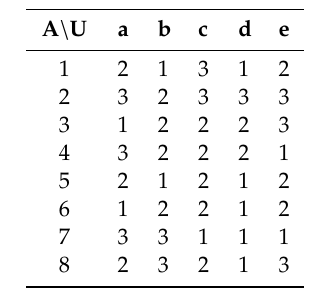
Table 2. Simplification table of the decision rules.